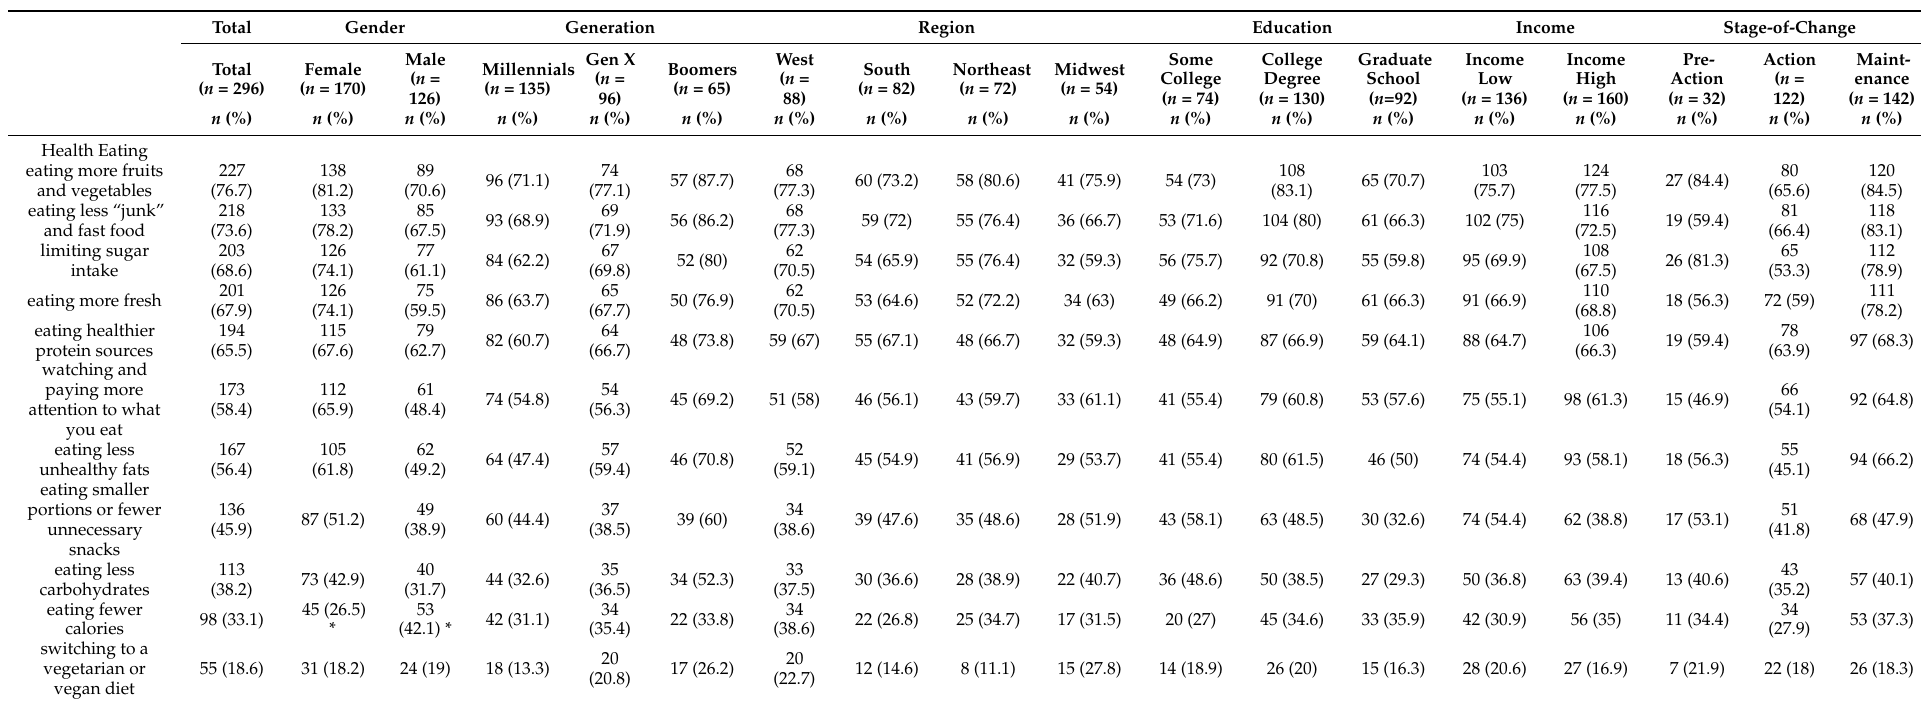
Table 3. Healthy eating of kombucha